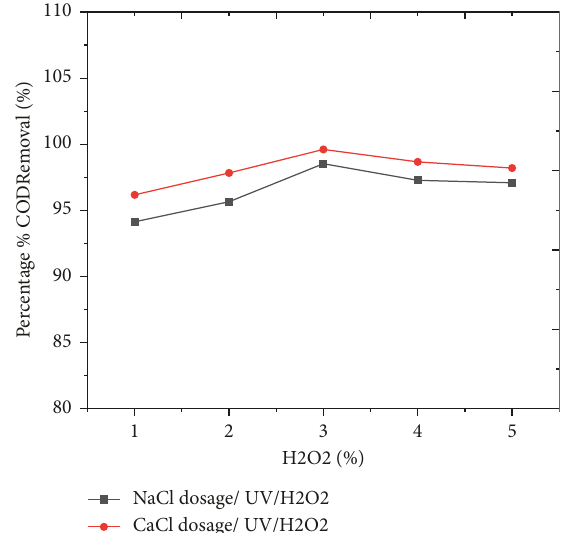
Figure 6: Effect of hydrogen peroxide on COD removal efficiency by using UV/H 2 O 2 and NaCl.